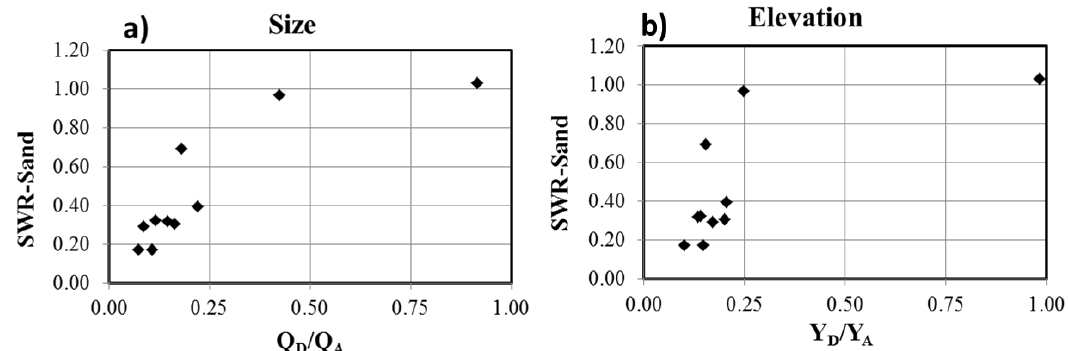
Figure 13. Correlation of SWR-Sand with ( a ) distributary channel capacity (Q D = flow entering distributary channel, QA = flow at delta apex) and ( b ) elevation (Y D = distributary channel depth, Y A = delta apex depth).